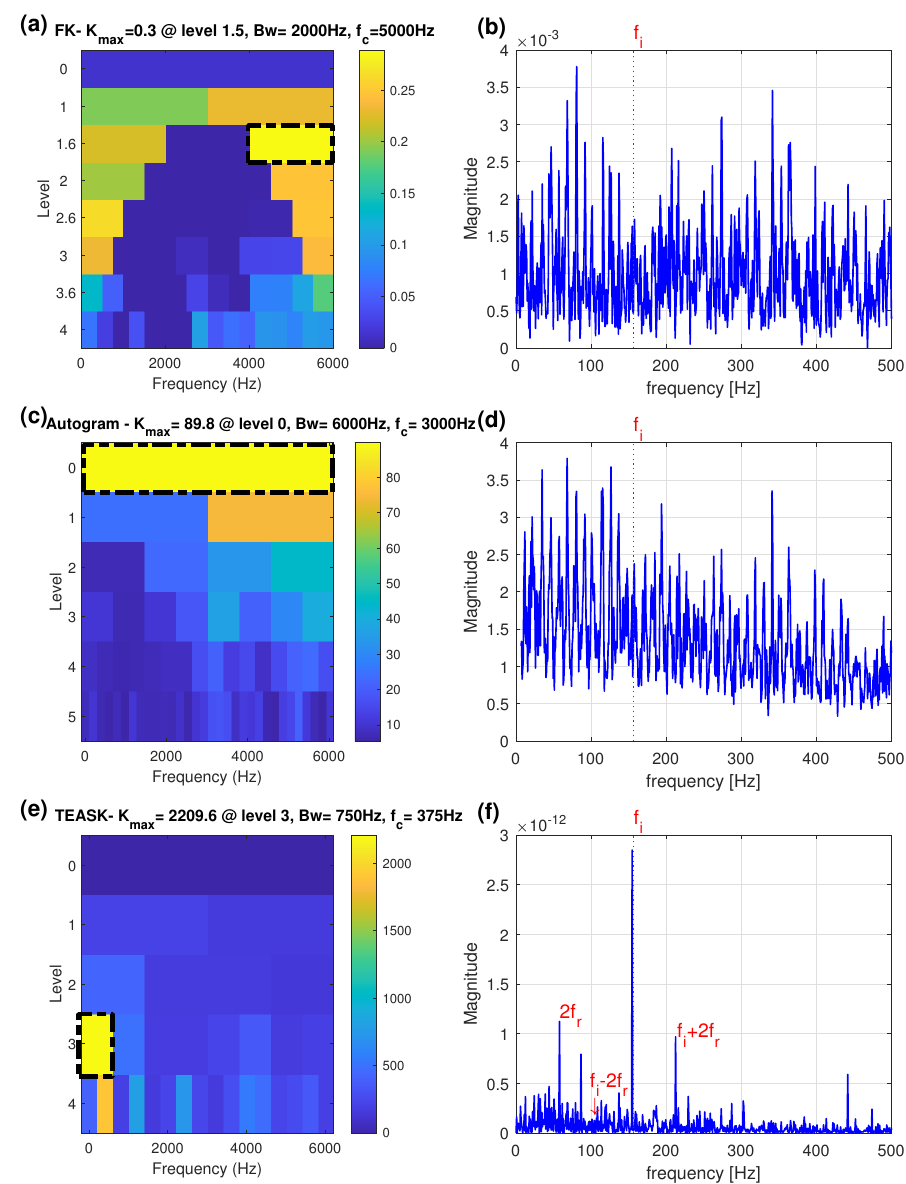
Figure 9. Faulty inner-race bearing: ( a ) the FK; ( b ) the SES obtained by the node with highest kurtosis of the FK; ( c ) the Autogram; ( d ) the combined SES obtained by the node with highest kurtosis of the Autogram; ( e ) the TEASK; ( f ) the TEPS obtained from the node with highest kurtosis of the TEASK. (The black dash-dot rectangle indicates the optimal frequency